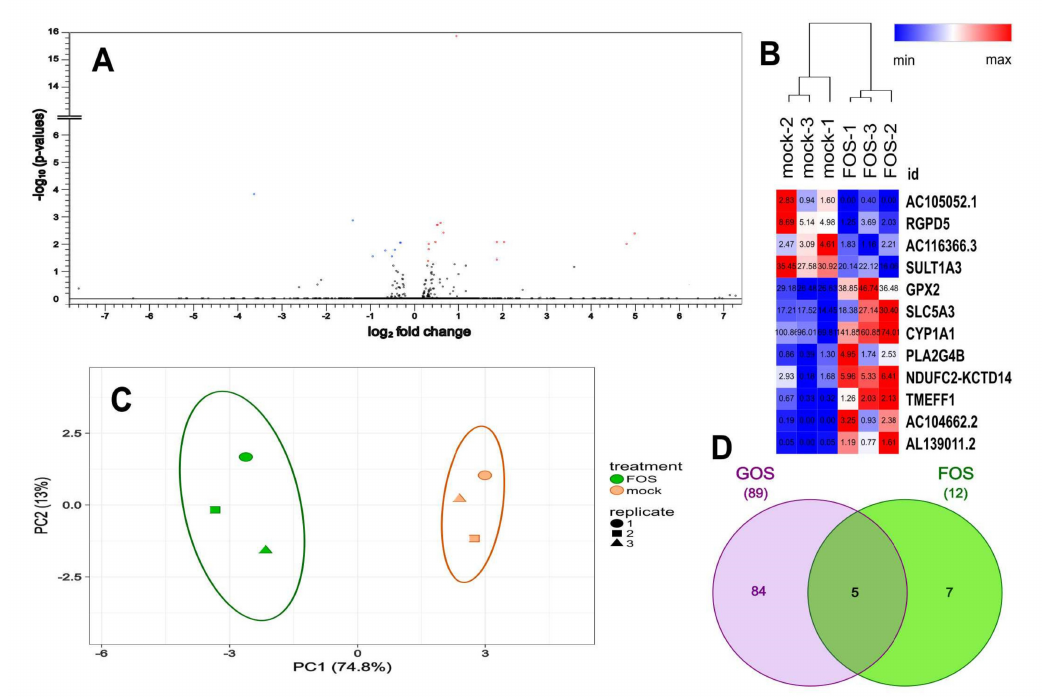
Figure 3. Di ff erentially expressed genes associated with FOS treatment. ( A ) Volcano plot of genes di ff erentially expressed between FOS and FOS mock treatment ( n = 3). The abscissa represents log 2 fold changes in gene expression, the ordinate represents statistical significance of the variations in gene expression, expressed as -log 10 ( p -values). ( B ) Principal component scatter plot showing variance of the biological replicates for each treatment ( n = 3). Axis x and y show principal components 1 (PC1) and 2 (PC2) that explain 74.8% and 13% of the total variance, respectively. Prediction ellipses indicate probability 0.95 that a new observation from the same group will fall inside the ellipse; N = 6 data points. ( C ) Heatmap displaying di ff erentially expressed genes for FOS and mock treatments. Rows and columns are clustered using Pearson’s correlation distance and average linkage. Data are presented as the normalized transcripts count (TPM) with | FC | ≥ 1.5 and q -value < 0.05. ( D ) Venn diagram showing the overlap of di ff erentially expressed genes between GOS and FOS treatments. Data are presented as the number of genes with | FC | ≥ 1.5 and q –value <